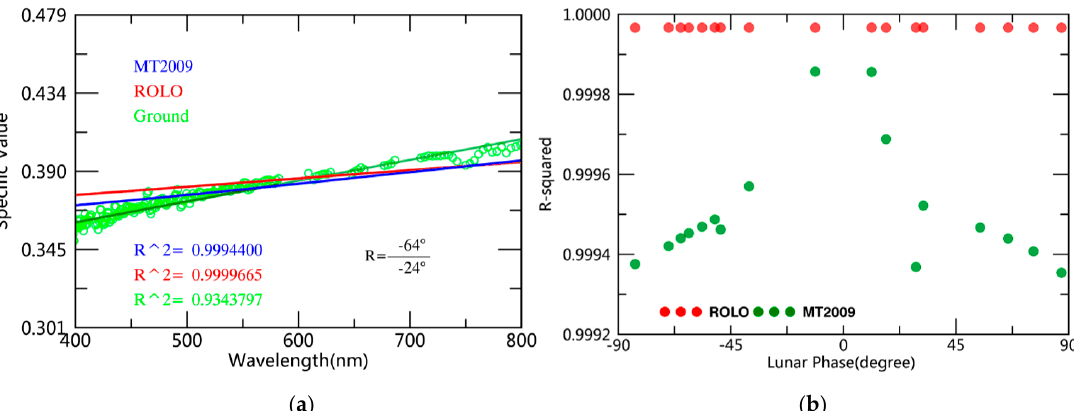
Figure 19 . Change of lunar color with phase angle. ( a ) phase reddening effect between different irradiances. The red line is the ROLO model, the green line is the MT2009 model and light green circles are the ground-based data. ( b ) fitting R-squared of the specific value with the luanr phase. Values are derived from multiple observations of the Moon in Lijiang city.